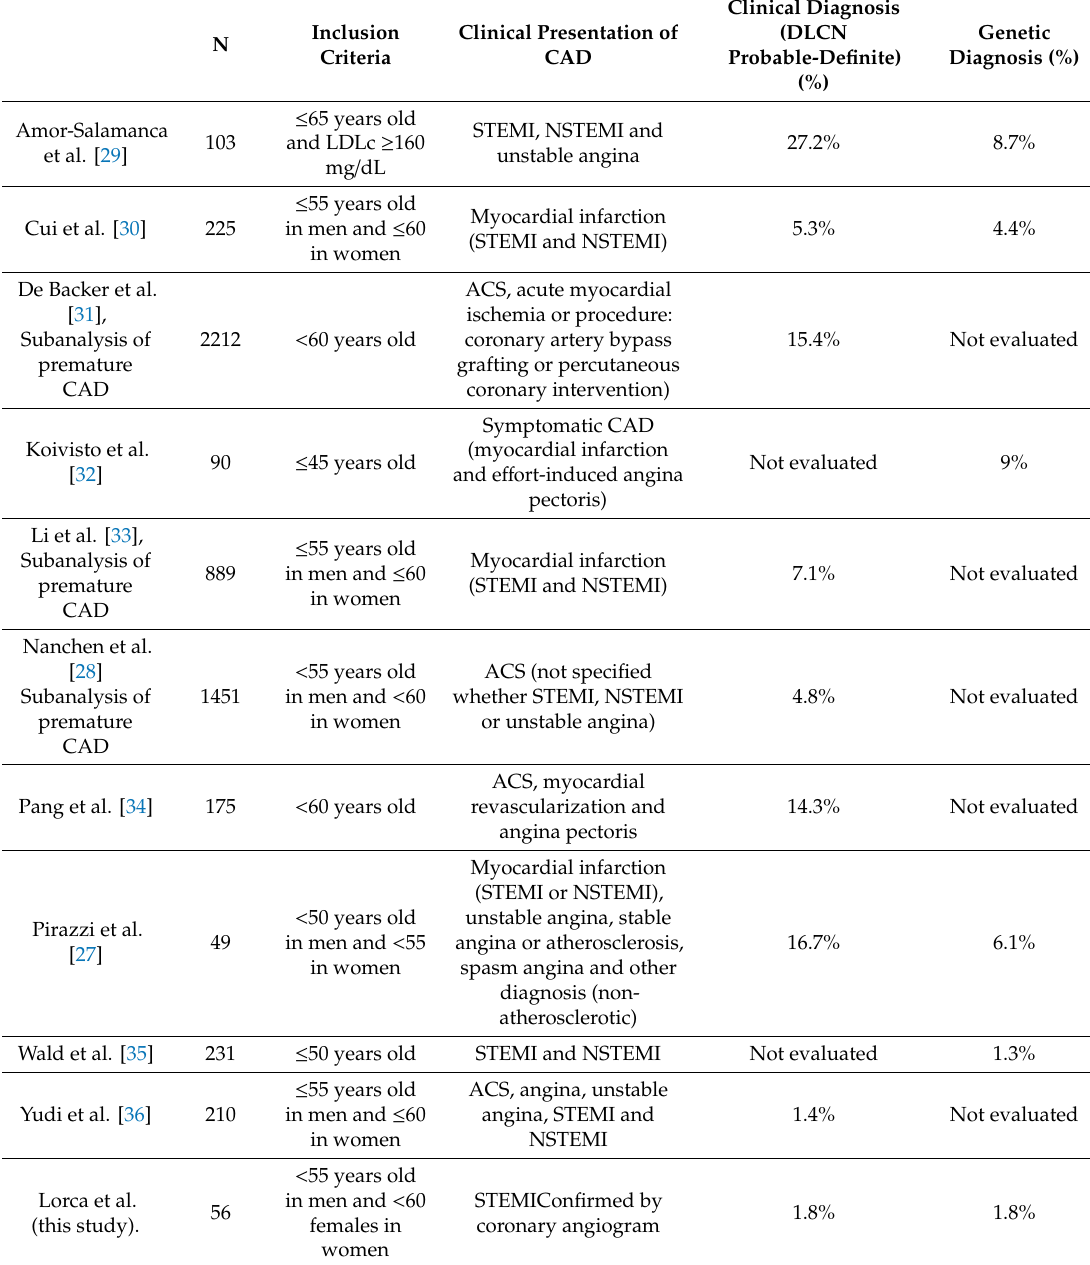
Table 3. Prevalence of familiar hypercholesterolemia in premature coronary artery disease according to di ff erent studies.